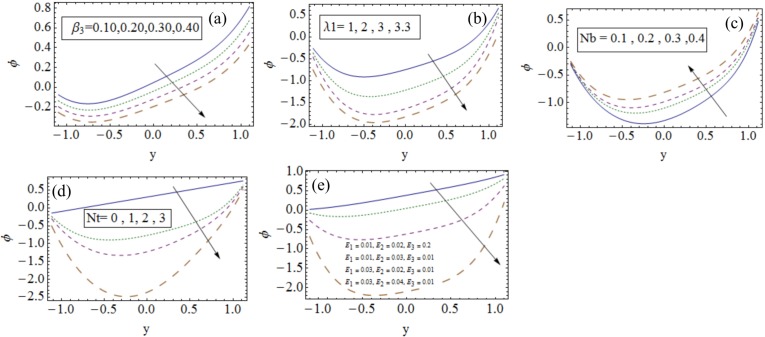
Influences of different parameters on nanoparticle concentration profile when (a). x = ϵ = 0.2, t = 0.1, Gr = 1, Qr = 0.3, Br = 0.5, Nt = Nb = 0.1, Pr = 1, M = 0.2, λ1 = 1, Rn = 1, β1 = β2 = 0.1, E1 = E3 = 0.01, E2 = 0.02. (b). x = ϵ = 0.2, t = 0.1, Gr = 0.8, Qr = 1, Pr = 1, Br = 1.7, M = 0.2, Rn = 1, β1 = β2 = β3 = 0.1, E1 = E3 = 0.01, E2 = 0.02. (c). x = ϵ = 0.2, t = 0.1, Gr = 0.8, Qr = 0.3, Br = 1.7, Nt = 0.1, Pr = 1, M = 0.2, λ1 = 1, Rn = 1, β1 = β2 = β3 = 0.1, E1 = E3 = 0.01, E2 = 0.02. (d). x = ϵ = 0.2, t = 0.1, Gr = 1, Br = 1.7, Qr = 0.3, λ1 = 1, Rn = 1, Nb = 0.3, Pr = 1, M = 0.2, β1 = β2 = β3 = 0.1, E1 = E3 = 0.01, E2 = 0.02. (e). x = ϵ = 0.2, t = 0.1, β1 = β2 = β3 = 0.1, Gr = 1, Qr = 0.3, Br = 0.5, Nt = Nb = 0.1, Pr = 1, M = 0.2, λ1 = 1, Rn = 1, β1 = β2 = β3 = 0.1.